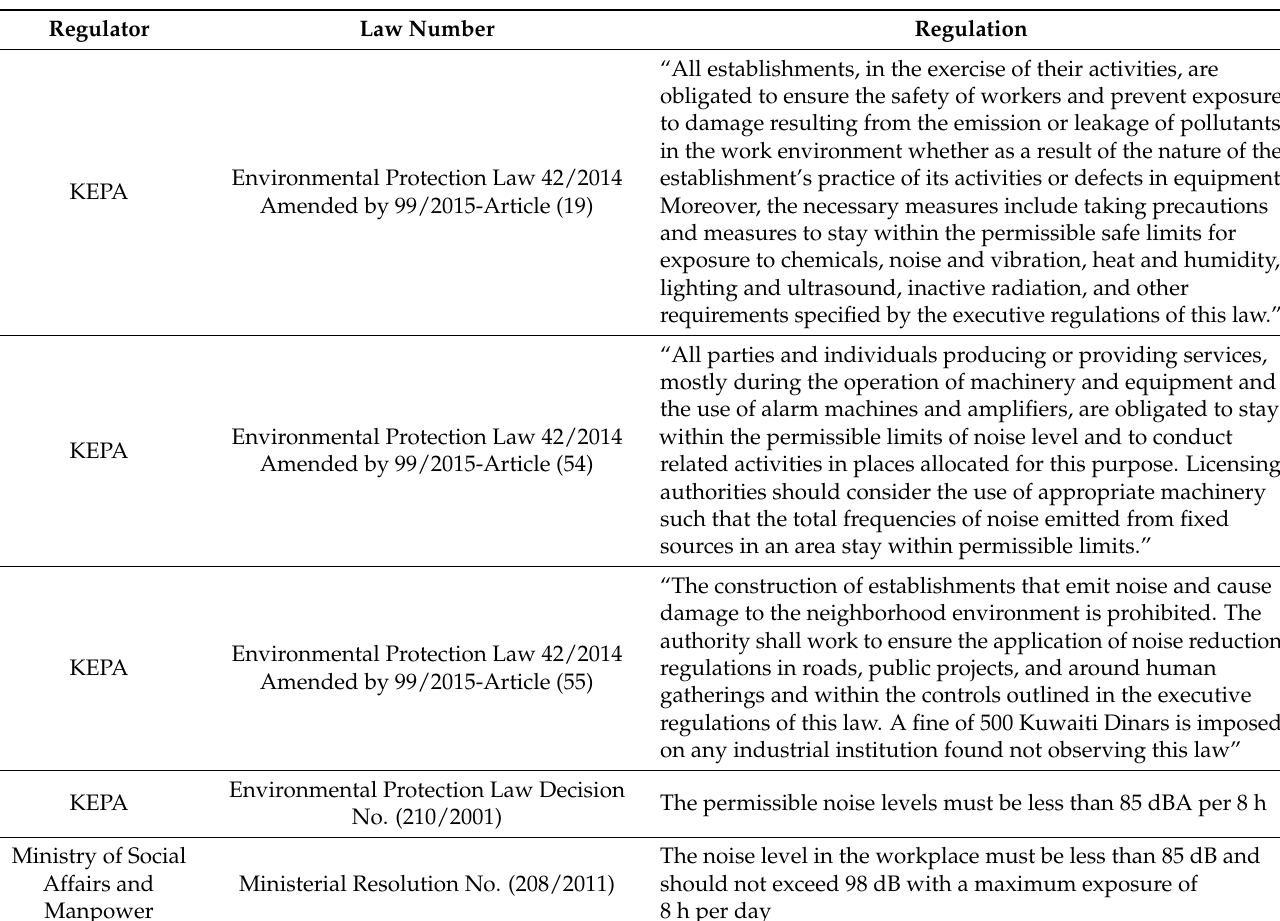
Table 4. Summary of workplace noise regulations in